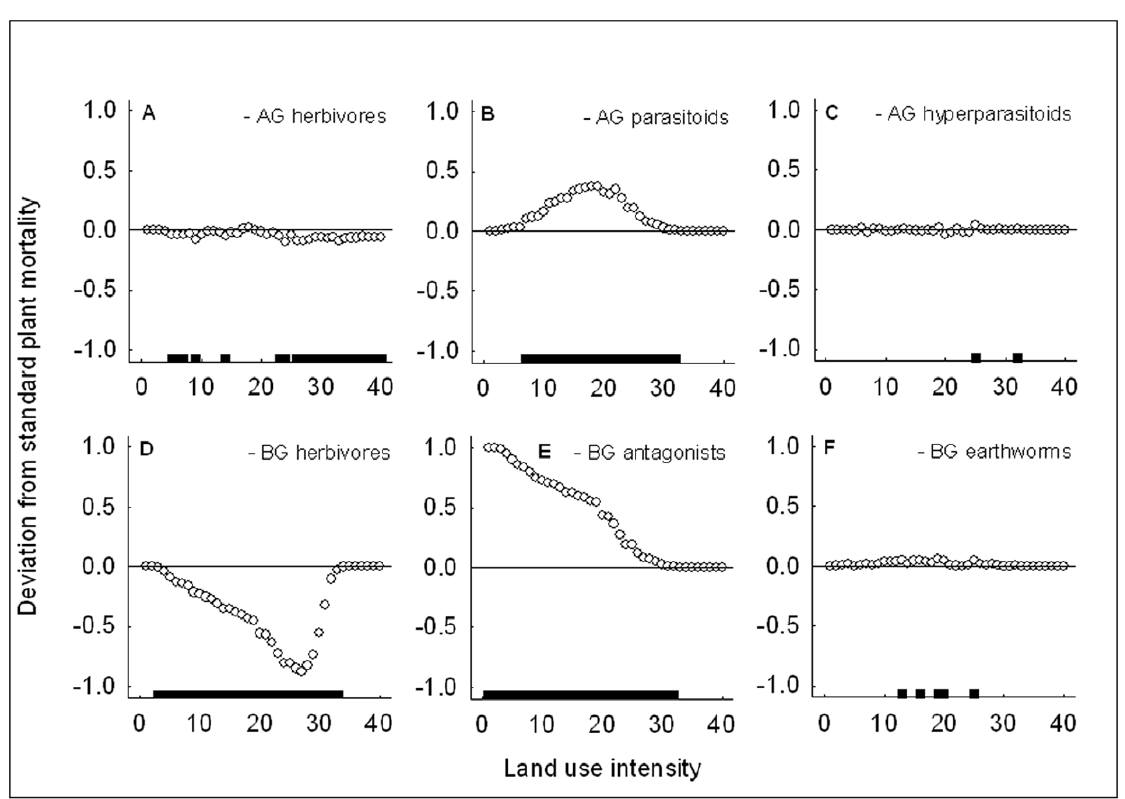
Figure 3. Plant mortality and multitrophic interactions with increasing land use intensity. Deviation from plant mortality in the standard scenario from low to high land use intensity after removal of aboveground (top row) and belowground (bottom row) trophic levels and earthworms, i.e. removal of aboveground (a) herbivores, (b) parasitoids, or (c) hyperparasitoids, or belowground (d) herbivores, (e) antagonists, or (f) earthworms. AG – aboveground, BG – belowground. The horizontal line at 0.0 represents the values of the standard scenario. Points indicate the difference in plant mortality between the respective removal scenario and standard scenario, and horizontal bars at the bottom of each graph indicate for each of the 40 points whether this difference is significant based on Pearson’s Chi-squared test statistic ( P , 0.05). Points above the 0.0-line show a positive effect of removal of the respective trophic level on plant mortality, points below the line a negative one. The horizontal bars show that belowground effects are more important under natural conditions while aboveground effects are stronger towards agroecosystems.